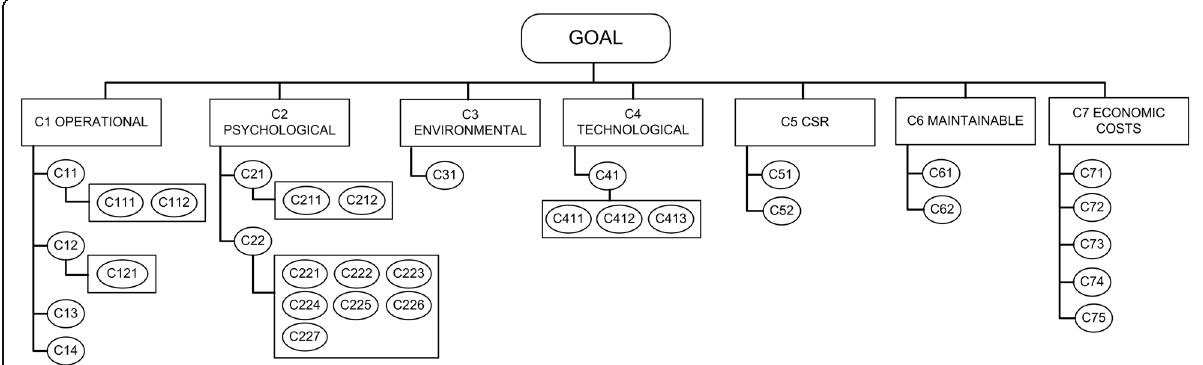
Fig. 4 Hierarchical model of barriers for the prototype presented in Fig.